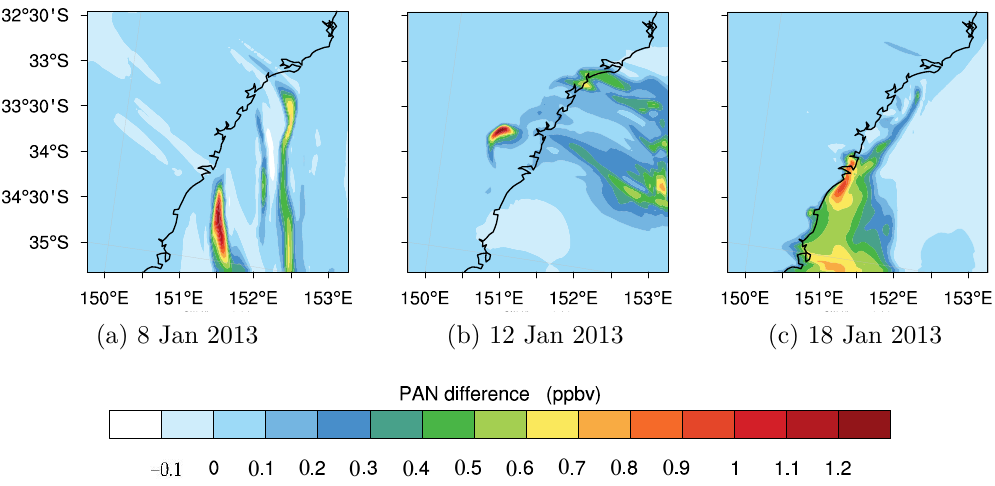
Figure 17. Simulated difference between PAN from standard run and PAN from average temperature run (STD_ET-AVG_T).